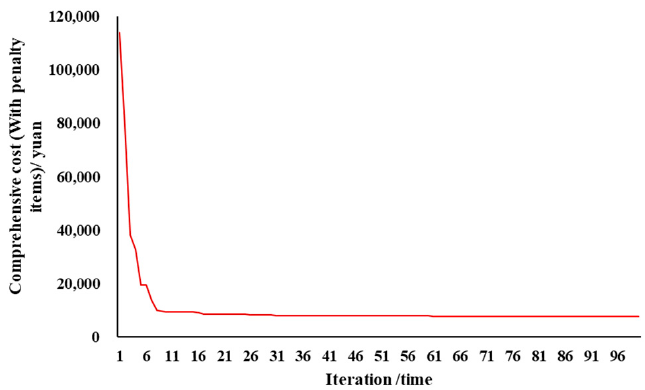
Figure 8. Convergence curve of the genetic algorithm.